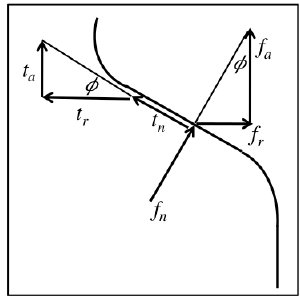
Figure 7: Forces acting on the V-band retainer.